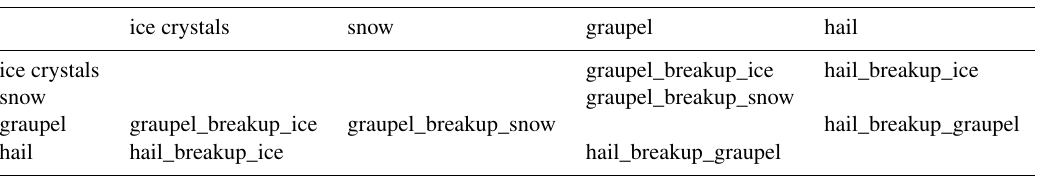
Table 2. Sensitivity tests are listed with ℵ RS in units of (mgrime) − 1 and T min , σ in Kelvin. Rime splintering Ice–ice collisional breakup RS1: ℵ RS = 300,